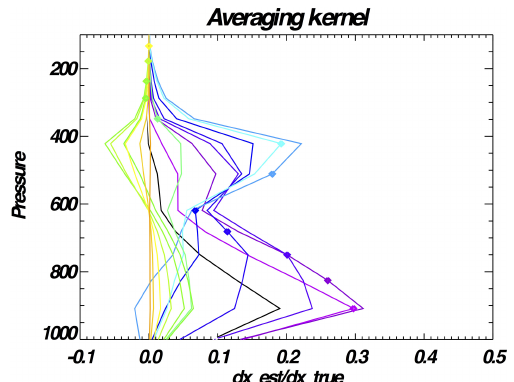
Figure 2. The rows of the averaging kernel matrix for the HDO re- trieval corresponding to the radiance shown in Fig. 1. The different colors and symbols are used to indicate the pressure levels corre- sponding to each row of the averaging kernel